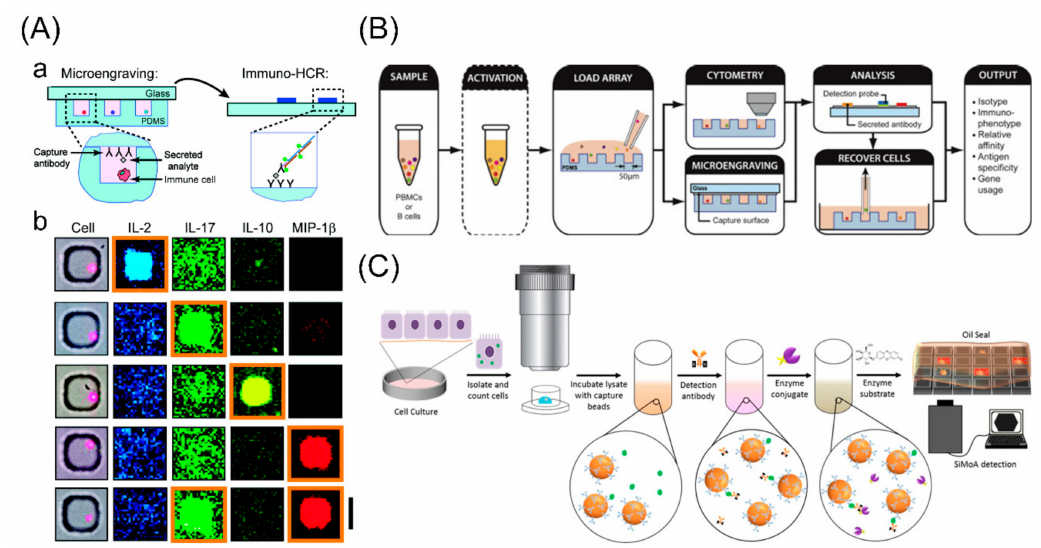
Figure 4. Microwell-based assay (microengraving) for single-cell protein analysis. ( A ) An integrated platform for microengraving and hybridization chain reaction. (a) Schematic illustration for detection of secreted products from single cells. Single cells are deposited onto an array of microwells on a glass slide with antibody coated. After incubation, the slide is removed, and immune-hybridization chain reaction is used to amplify the signal related to each capture event; (b) fluorescent micrographs for secreted proteins following microengraving and immune-hybridization chain reaction. Adapted with permission from [86]. ( B ) Process schematic for the integrated analysis of B cells using